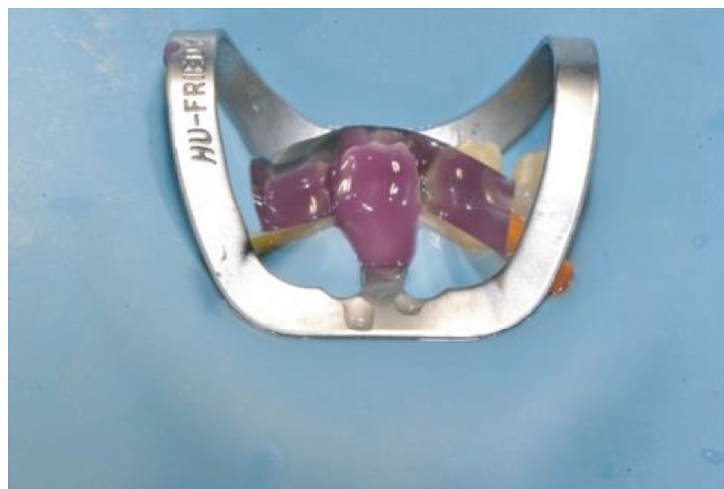
Figure 9: Tooth etching 35% H